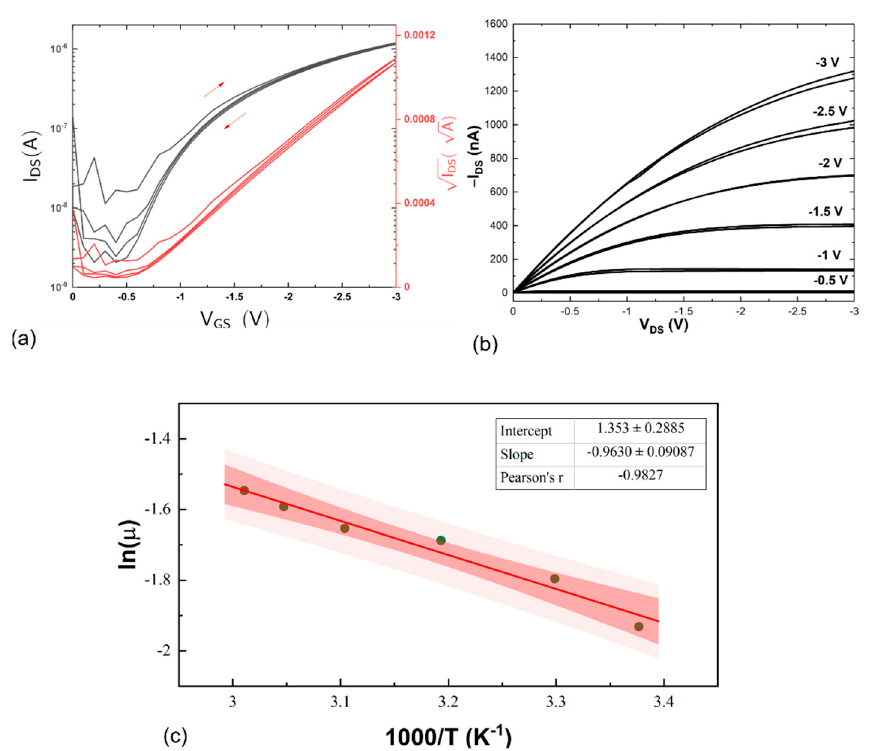
Figure 3. ( a ) Transfer curve used to establish the operating characteristics of the OFET devices— the devices were scanned 4 times between 0 and − 3 V V GS to observe the hysteresis of the devices; ( b ) the output curve at different V GS voltages between 0 to − 3 V; and ( c ) the Arrhenius plot of the dependence of mobility with temperature established an E a of 82 mV.